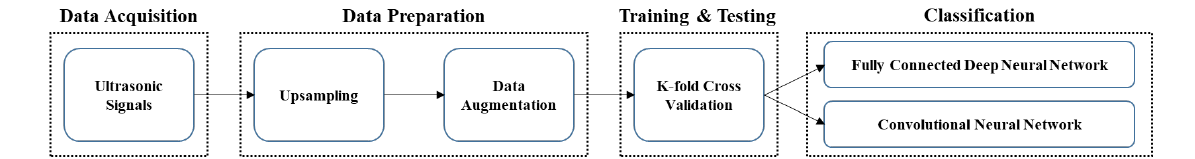
Figure 1. Overview of the scheme of the classification for resistance welding conditions of electrodes.